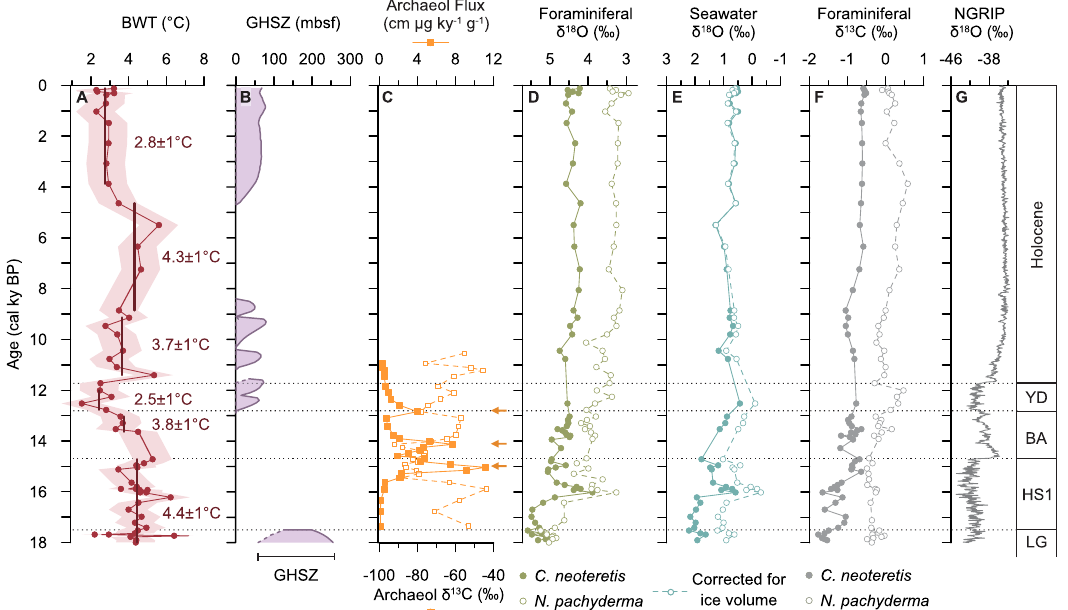
Fig. 3 Bottom water temperature in the Pingo Area, stable isotopes, methane seepage, and evolution of the gas hydrate stability zone (GHSZ). A Reconstructed bottom water temperature (BWT) derived from benthic foraminiferal Mg/Ca. The shaded area indicates the uncertainty interval calculated with error propagation. Thick vertical lines represent the average BWT for each interval. For the Bølling-Allerød interval, the average only represents the Allerød interstade due to the lack of data points during Bølling. B Top (dashed line) and base (solid line) of the gas hydrate stability zone (GHSZ), which is represented by the colored area. C Archaeol fl ux and archaeol carbon isotopes from core 920 24 (see “ Methods ” section). Methane seepage events shown by these data are indicated with the dark orange arrows. D Benthic ( Cassidulina neoteretis ) and planktic ( Neogloboquadrina pachyderma ; dashed lines) foraminiferal oxygen isotopes. E Seawater oxygen isotopes were calculated using bottom water temperature and benthic δ 18 O calcite (continuous line) and corrected for ice volume (dashed line). F Benthic ( C. neoteretis ) and planktic ( N. pachyderma ; dashed lines) carbon isotopes. G NGRIP ice core δ 18 O record in the GICC05modelext timescale 23,62 . LG: Late Glacial; HS1: Heinrich Stadial 1; BA: Bølling-Allerød interstadials; YD: Younger Dryas